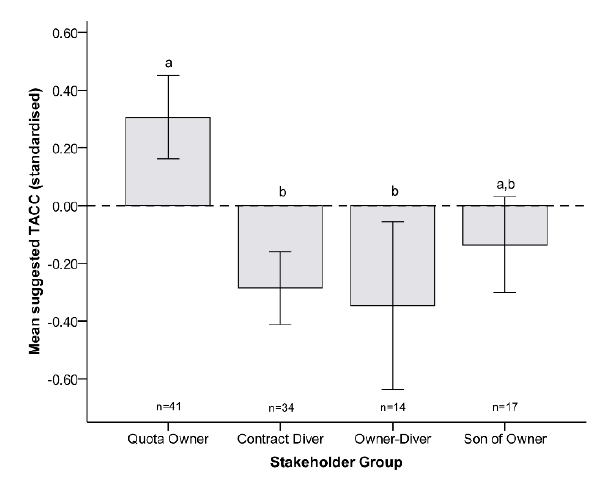
Fig. 2 . Standardized total allowable commercial catch (TACC) suggested by different stakeholder groups, pooled across fisheries. The standardized values provide a relative measure of what individuals considered the TACC should be, compared to the mean response for each fishery; positive values indicate responses higher than the mean; negative values indicate responses lower than the mean. Error bars equal ±1